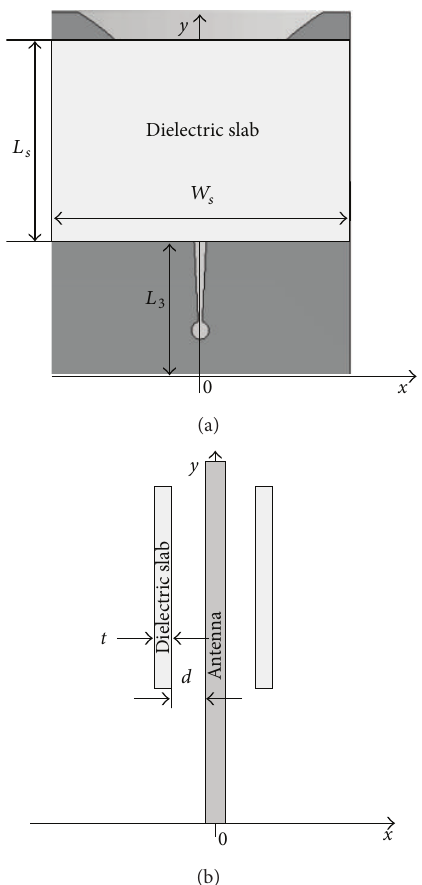
Figure 6: Geometry of the improved Vivaldi antenna: (a) top view and (b) lateral